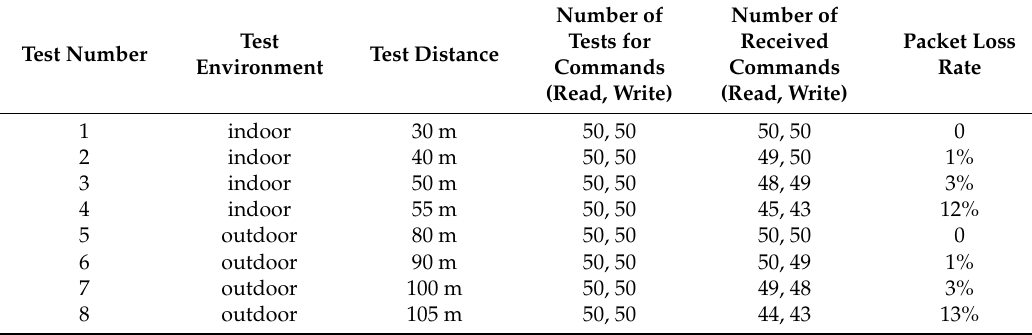
Table 1. The test results of transmission distance between the ZigBee sensor node and the RFID reader/router